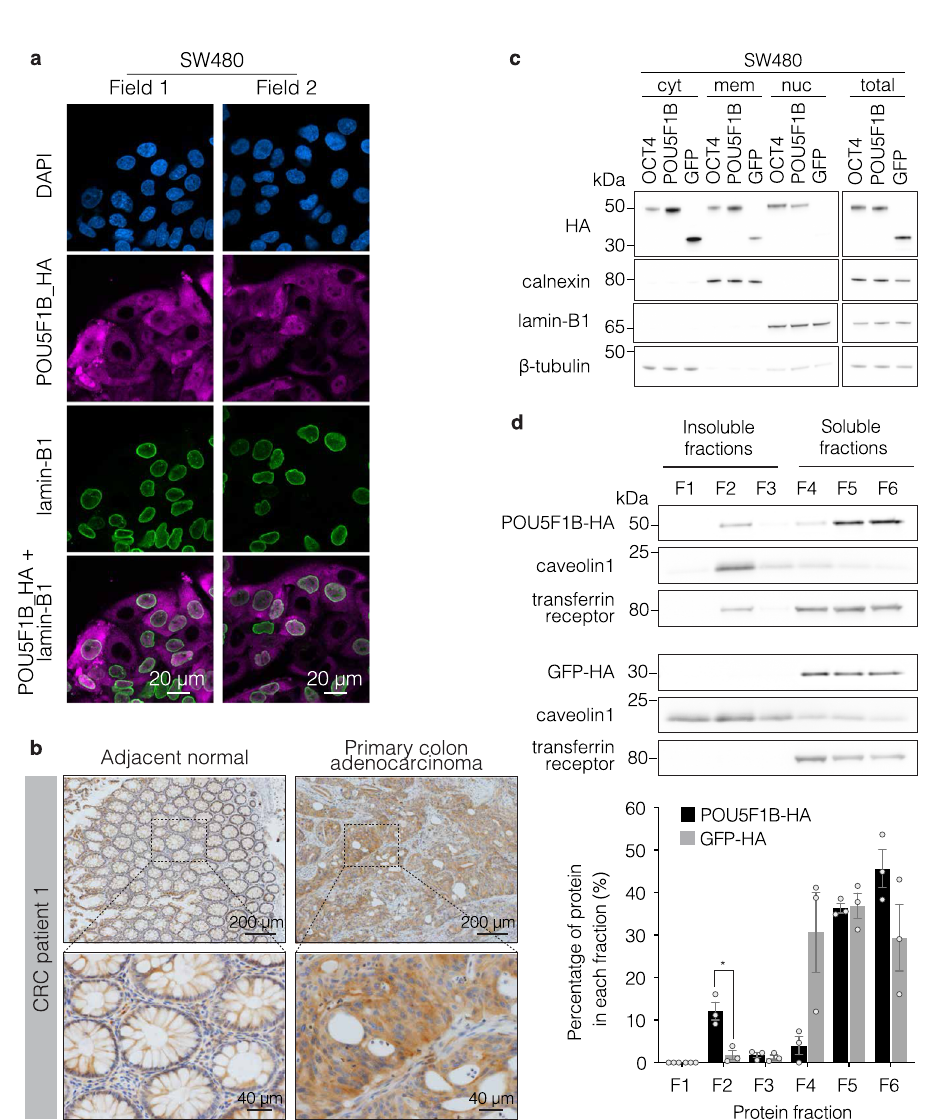
Fig. 4 | POU5F1B differs from OCT4. a Representative immuno fl uorescence – confocal microscopy of POU5F1B-HA overexpressing SW480 cells, with DAPI in blue, HA in pink, and the nuclear membrane marker lamin-B1 in green. Two fi elds out of eight are shown. b Immunohistochemistry for endogenous POU5F1B in adjacent normal colon and primary colon adenocarci- noma samples from CRC patient 1. Two levels of magni fi cation from a repre- sentative fi eldoutofthreeareshown.MorepatientsaredepictedinSupplementary Fig4e. c Subcellularfractionationintothecytoplasm(cyto),membrane(mem),and nuclear (nuc) compartments from OCT4-, POU5F1B- and GFP-overexpressing SW480 cells, with total cell extracts on right. Calnexin, lamin-B1, and beta-tubulin